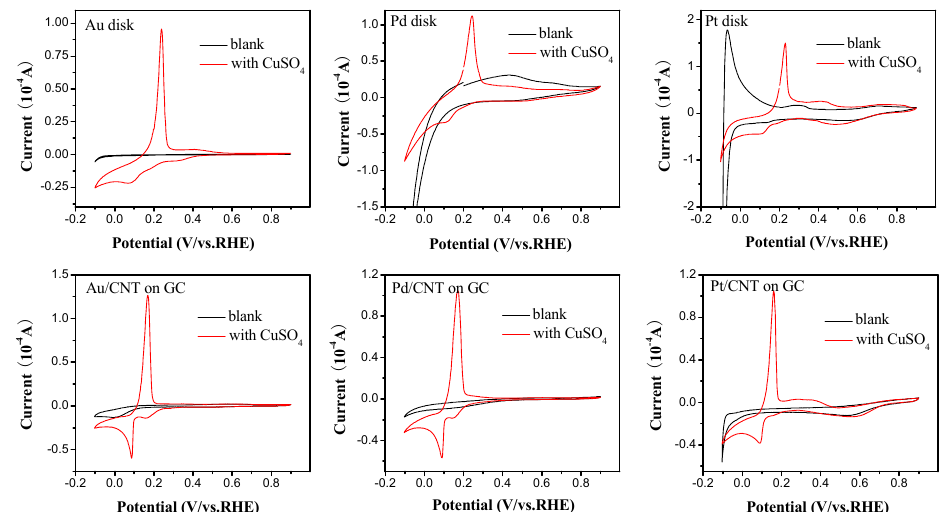
Figure 4. Cyclic voltammograms (100 mV s − 1 ) of Cu-UPD in 0.5 M H 2 SO 4 in the absence and presence of 1 mM CuSO 4 .